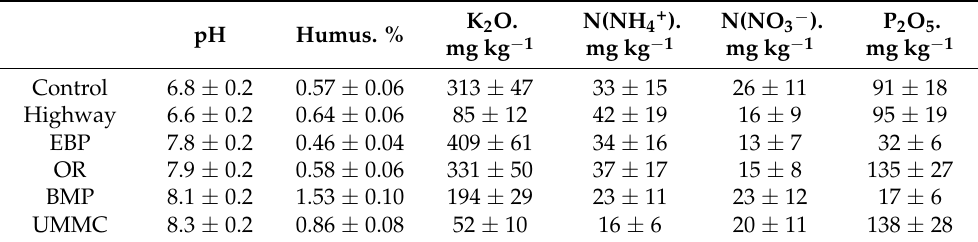
Table 2. Soil characteristics in the studied area. K 2 O. N(NH 4+ pH Humus. %